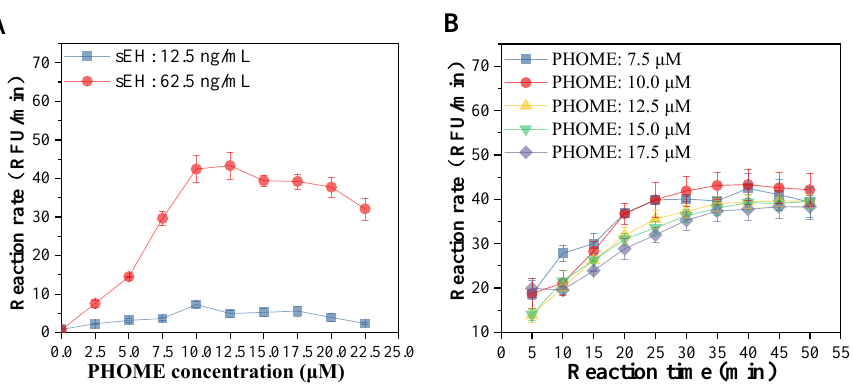
Figure 1. Effects of PHOME concentration ( A ) and reaction time ( B ) on the reaction rate of the hydrolase of sEH.